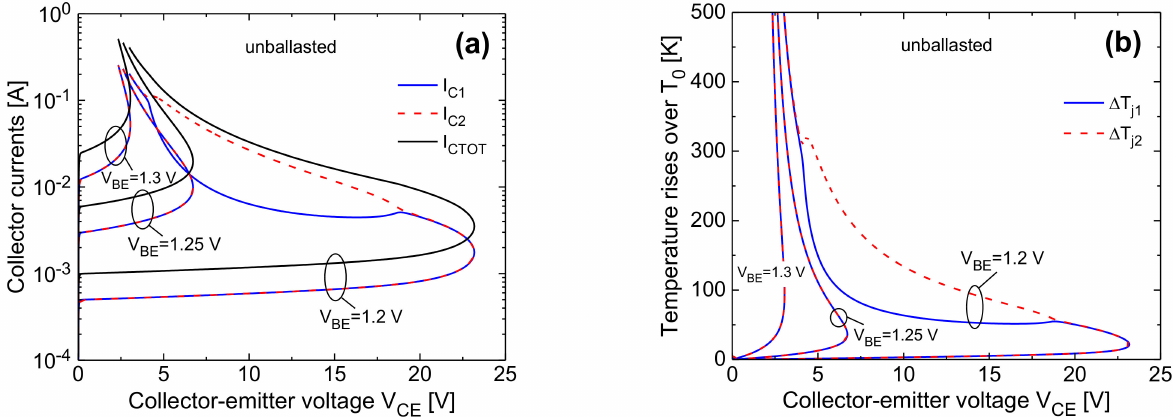
Figure 13. Unballasted test device with two unit cells: simulated ( a ) collector currents and ( b ) temperature rises over T 0 vs. collector-emitter voltage V CE for V BE = 1.2, 1.25, 1.3 V.